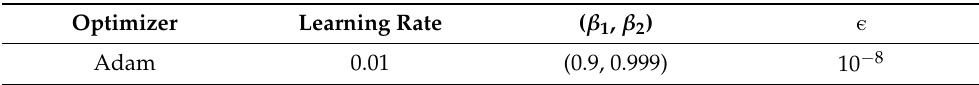
Table 1. Optimizer parameter table.